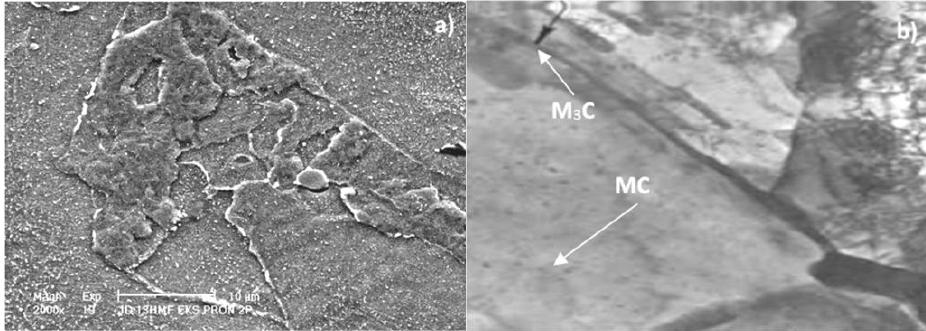
Figure 2. Structure image of 14MoV6-3 ferritic-bainitic steel in the as-received condition ( a ) SEM; ( b )